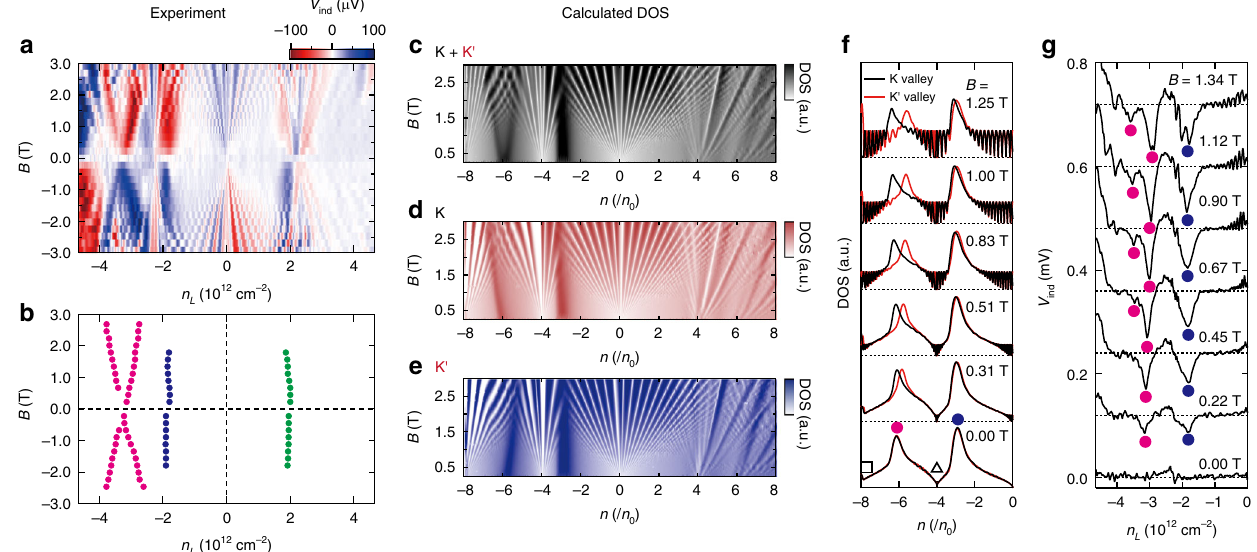
Fig. 3 Valley splitting of the thermoelectric voltage at van Hove singularity. a V ind as a function of n L and B . b Peak positions of V ind at each vHS obtained from a plotted as a solid magenta circle (second hole-side vHS), solid blue circle ( fi rst hole-side vHS), and solid green circle ( fi rst electron-side vHS). c – e Calculated DOS as a function of the normalized carrier density n / n 0 and B under the condition of c total DOS including both K and K ′ valley, d DOS of K valley, and e DOS of K ′ valley. f DOS with respect to the normalized carrier density n / n 0 calculated at different magnetic fi eld values. Traces are offset for clarity and offset is depicted by black dashed lines. The positions of DPs and vHSs are indicated by solid magenta circle (second hole-side vHS), solid blue circle ( fi rst hole-side vHS), open square (holes-side TDP), and open triangle (hole-side SDP), respectively. g V ind as a function of the carrier density n L measured at a different out-of-plane magnetic fi eld B measured at 2.0 K. Traces are offset for clarity and offset is depicted by black dashed lines. These are same data as Fig.